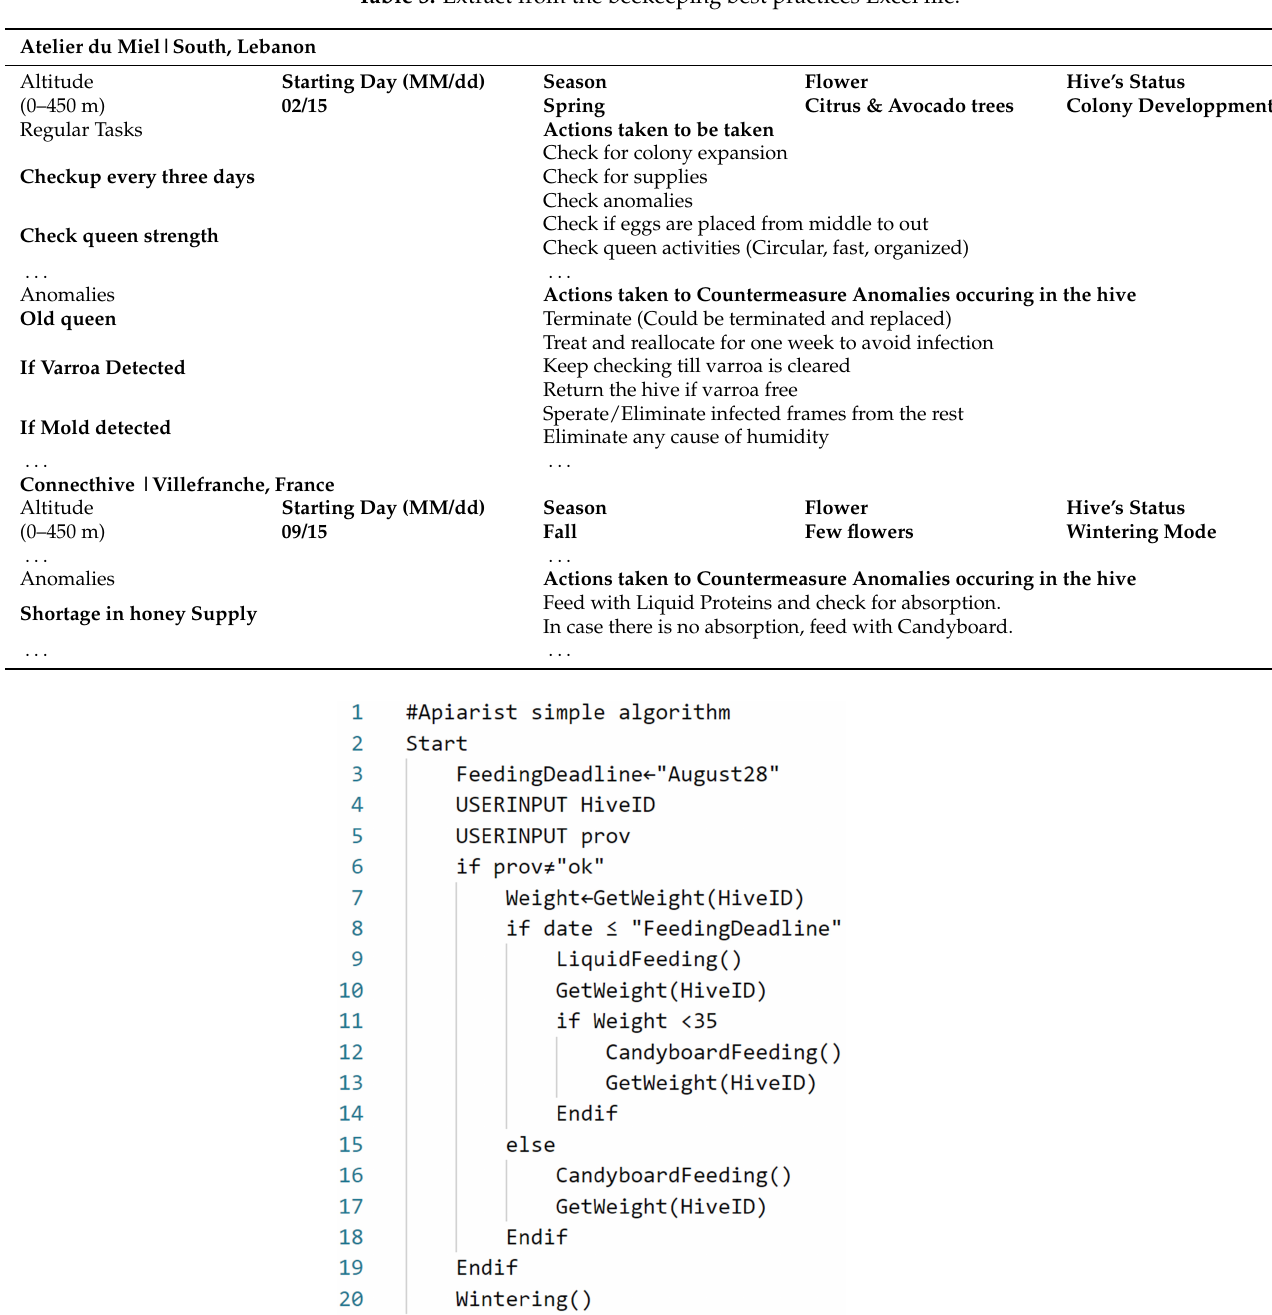
Table 3. Extract from the beekeeping best practices Excel file.